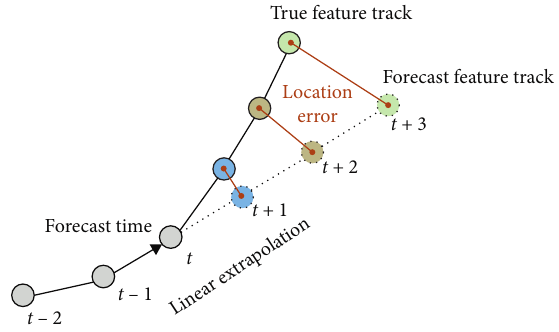
Figure 1: Illustration of the location error for a prediction at forecast time t that is based on the linear extrapolation of feature motion from t − 1 to t